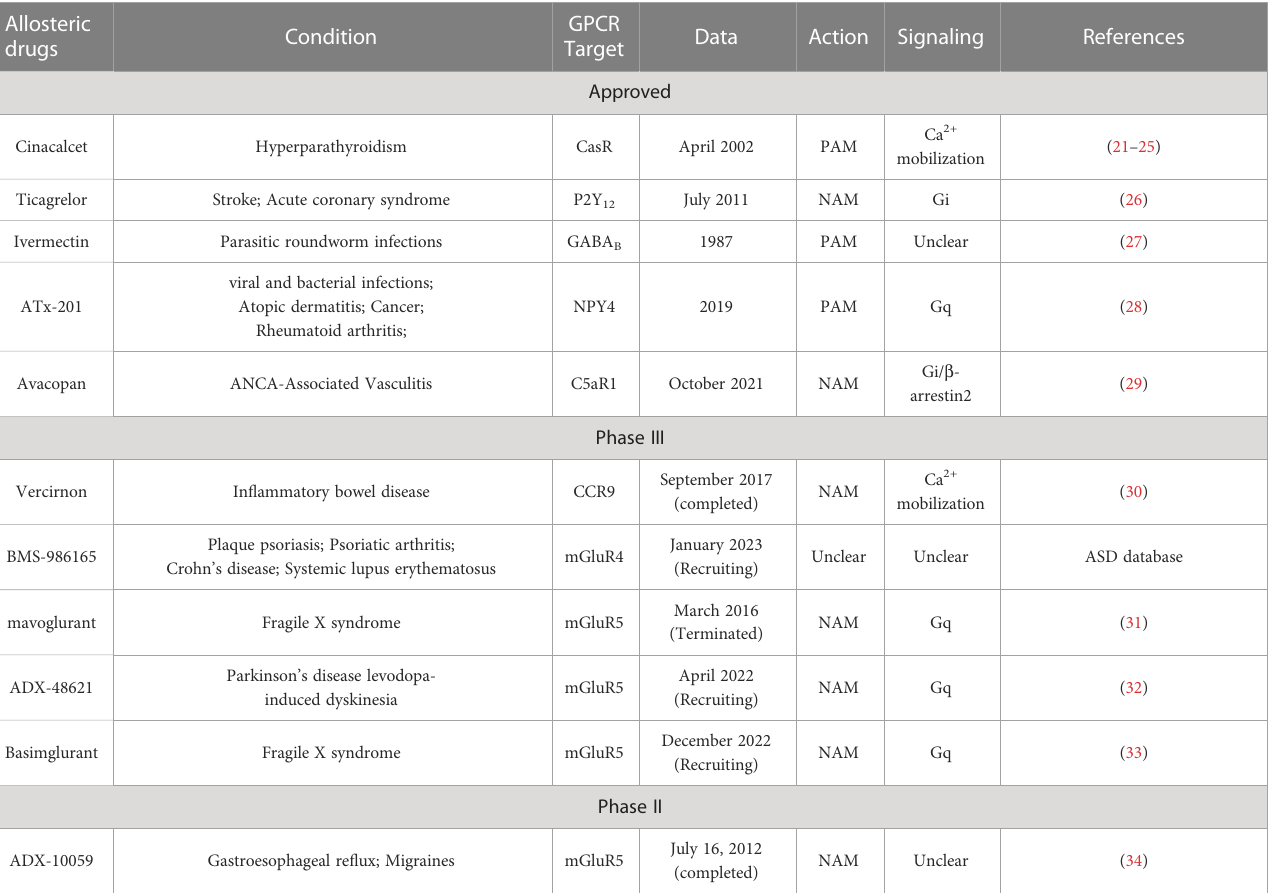
TABLE 1 List of allosteric drugs target GPCR in clinical trials. Allosteric